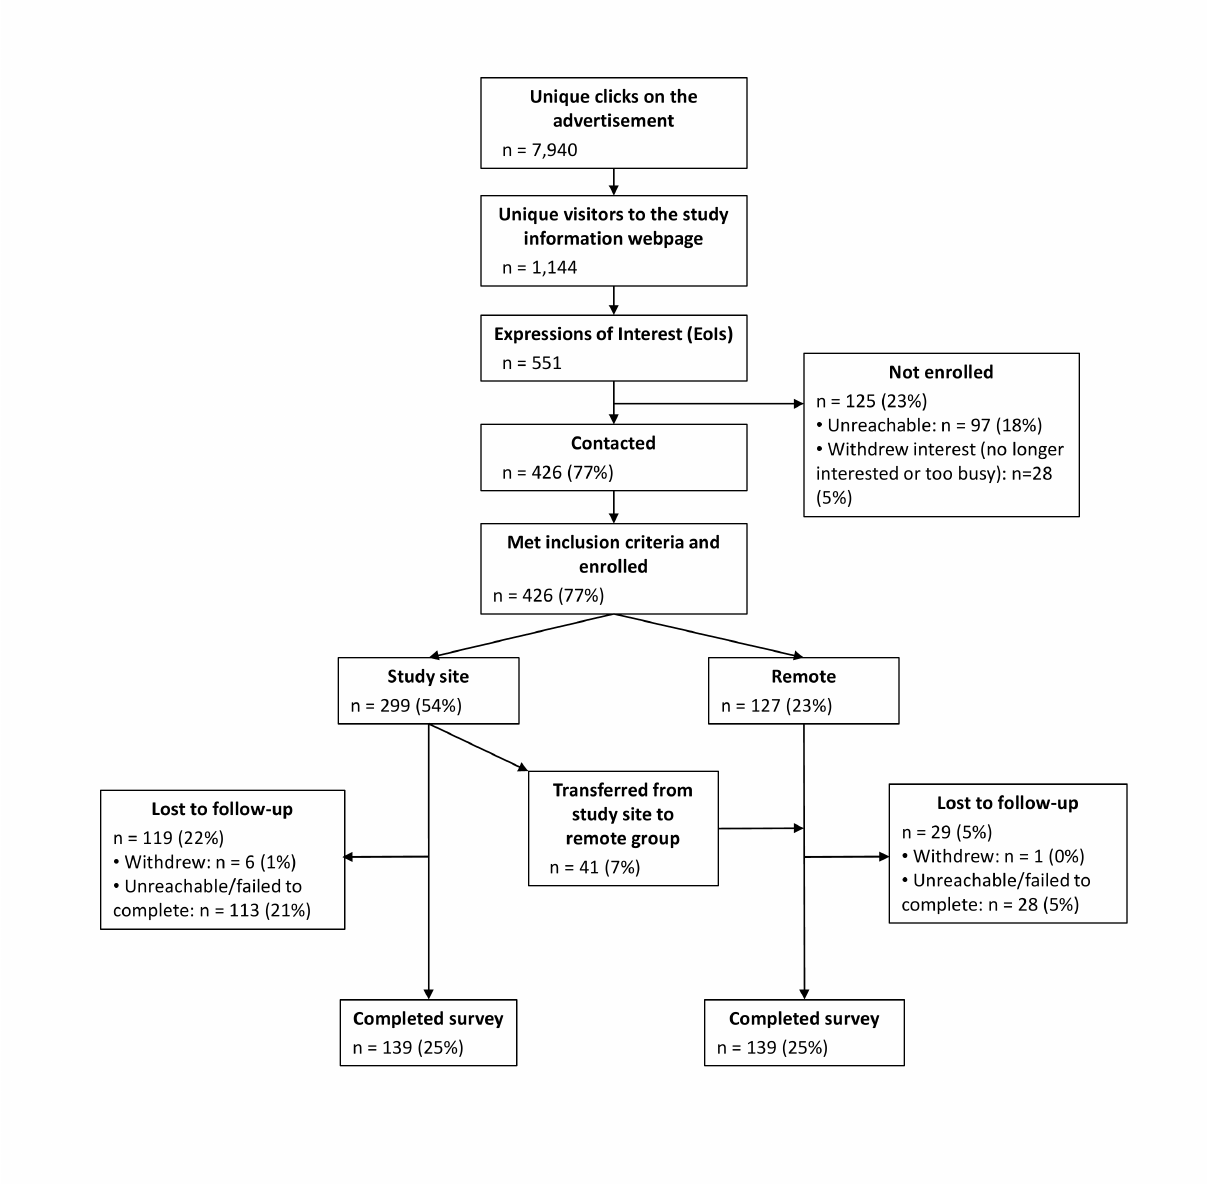
Figure 2. Summary of sampling and response. Percentages are calculated using the number of expressions of interest (551) as the